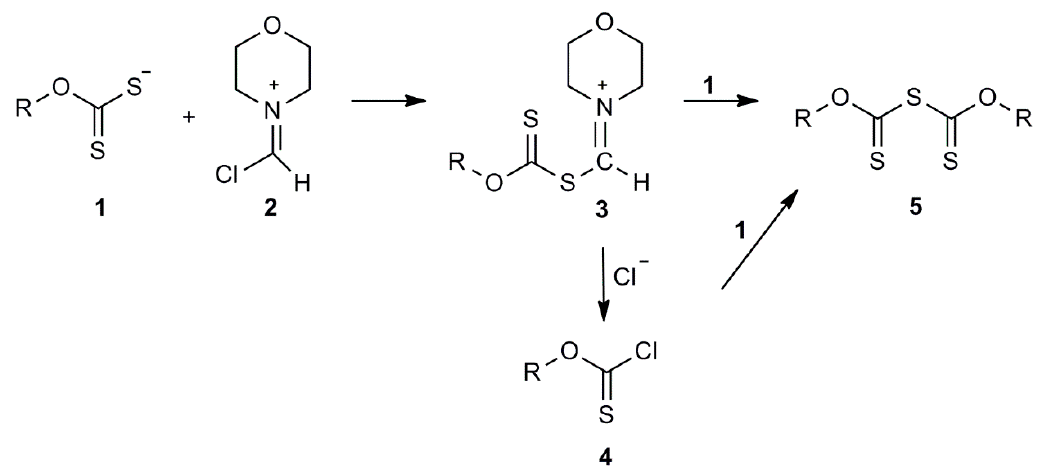
Figure 3. Alkyl chlorothioformate synthesis by reaction of alkyl xanthates and Vilsmeier reagent.